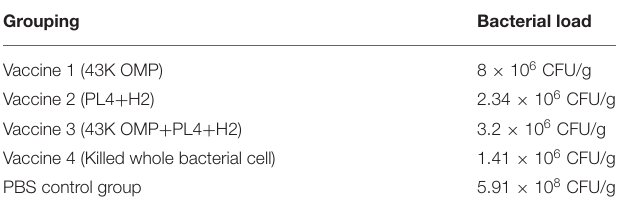
TABLE 3 | Female BALB/c mice liver bacterial load. Grouping Bacterial load